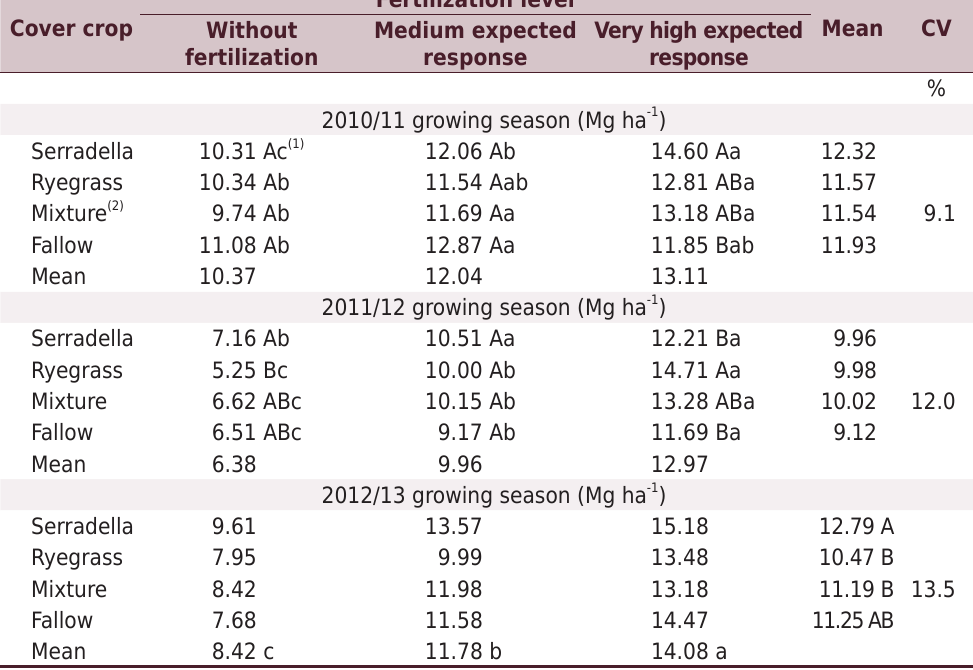
Table 2. Plant density of rice grown in succession to cover crops in three growing seasons Cover crop Growing season Serradella Ryegrass Mixture (1) Fallow plants per m 2 % 2010/11